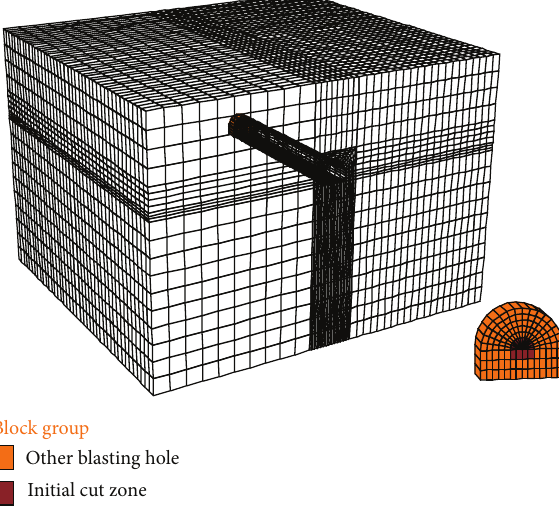
Figure 7: 3D model in numerical